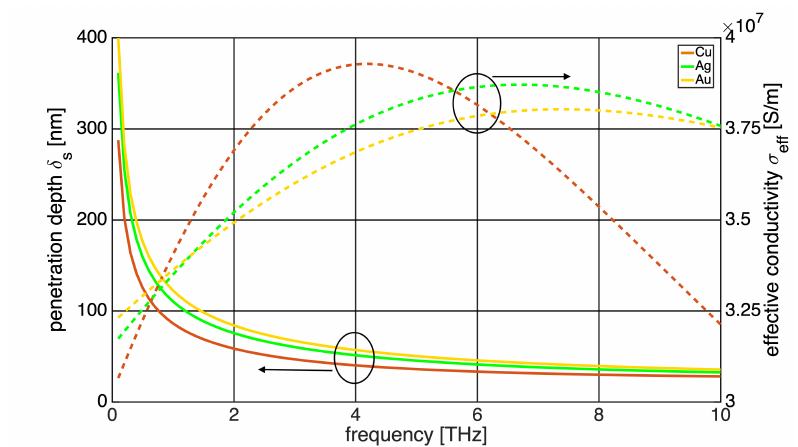
Figure 2. Penetration depth (continuous lines) δ s in nm (see (21)), and effective conductivity (dotted lines) σ ef f in S/m (see (3)) for the cases of Cu, Ag, and Au at 0.1–10 THz frequency range, using the Drude model for the determination of electric permittivity.